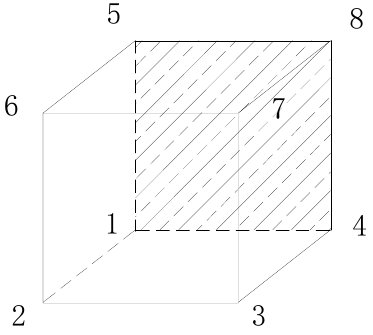
Figure 4. Typical unit diagram of drainage hole treatment.